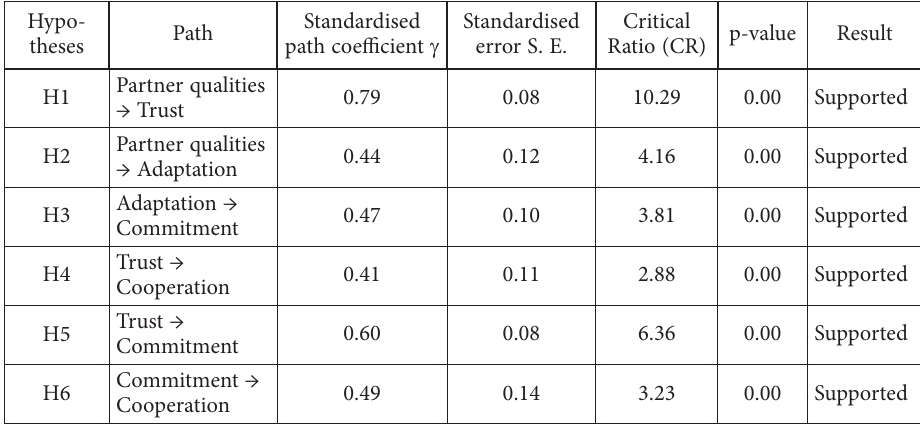
Table 4. Results of the structural model